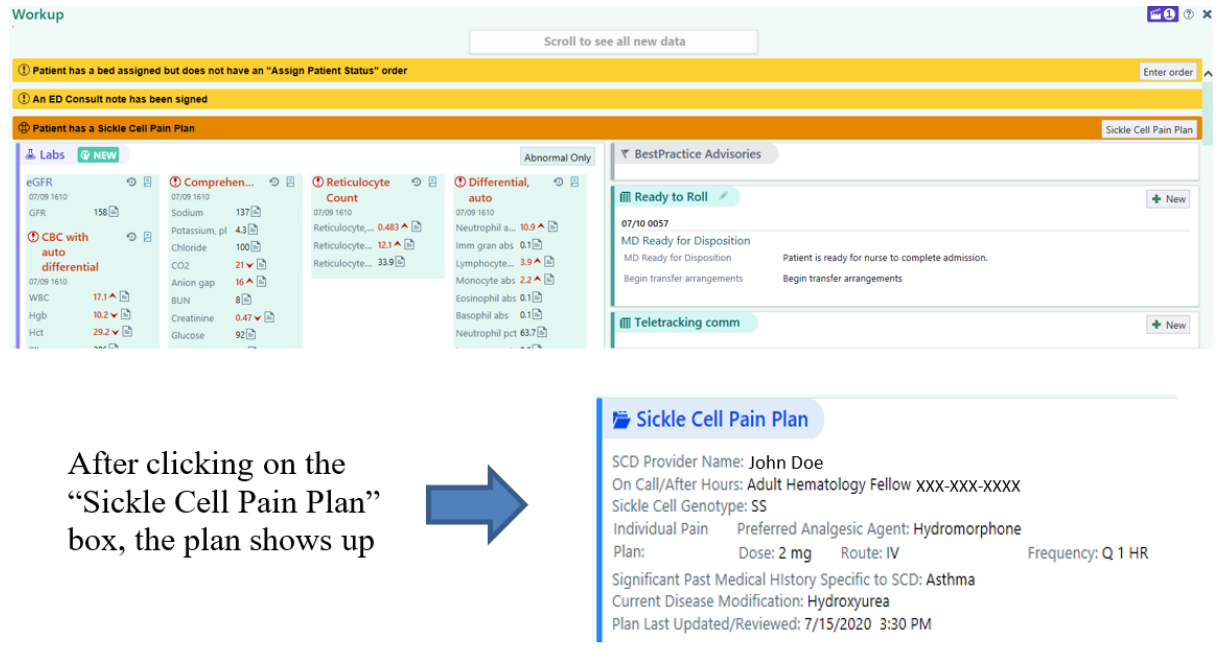
Figure 1. An example of an E-IPP emergency department provider interface (Washington University). E-IPP: electronic health record–embedded individualized pain plan.